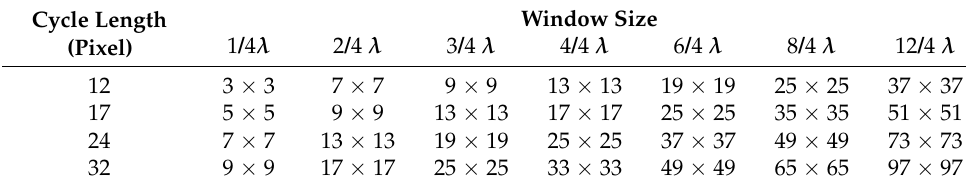
Table 2. The windows size for each pixel-cycle length of the